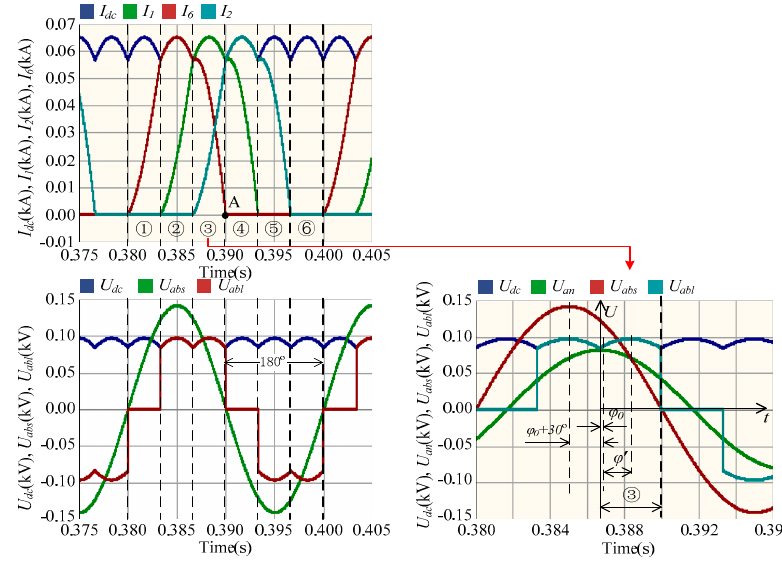
Figure 4. The waveform of steady-state quantities in Figure 3: I dc , I 1 , I 2 , and I 6 (in kA); U dc , U abl , U abs and U an (in kV).